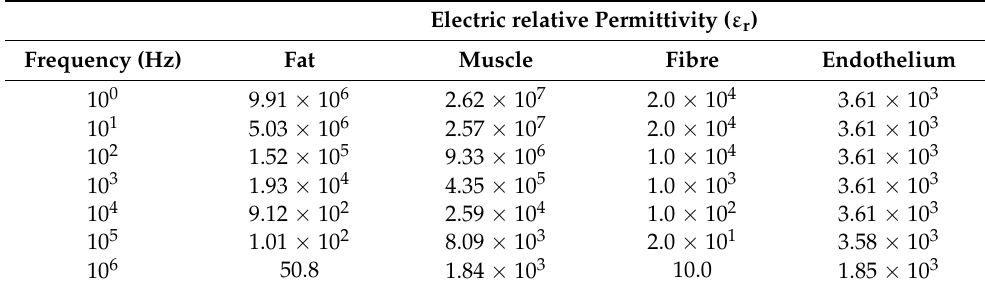
Table 2. Electrical properties of the different layers modelled. Electrical conductivity values and Table 3. Electric permittivity values used in our model, at different frequencies electric permittivity values used in our model, at different frequencies [11].